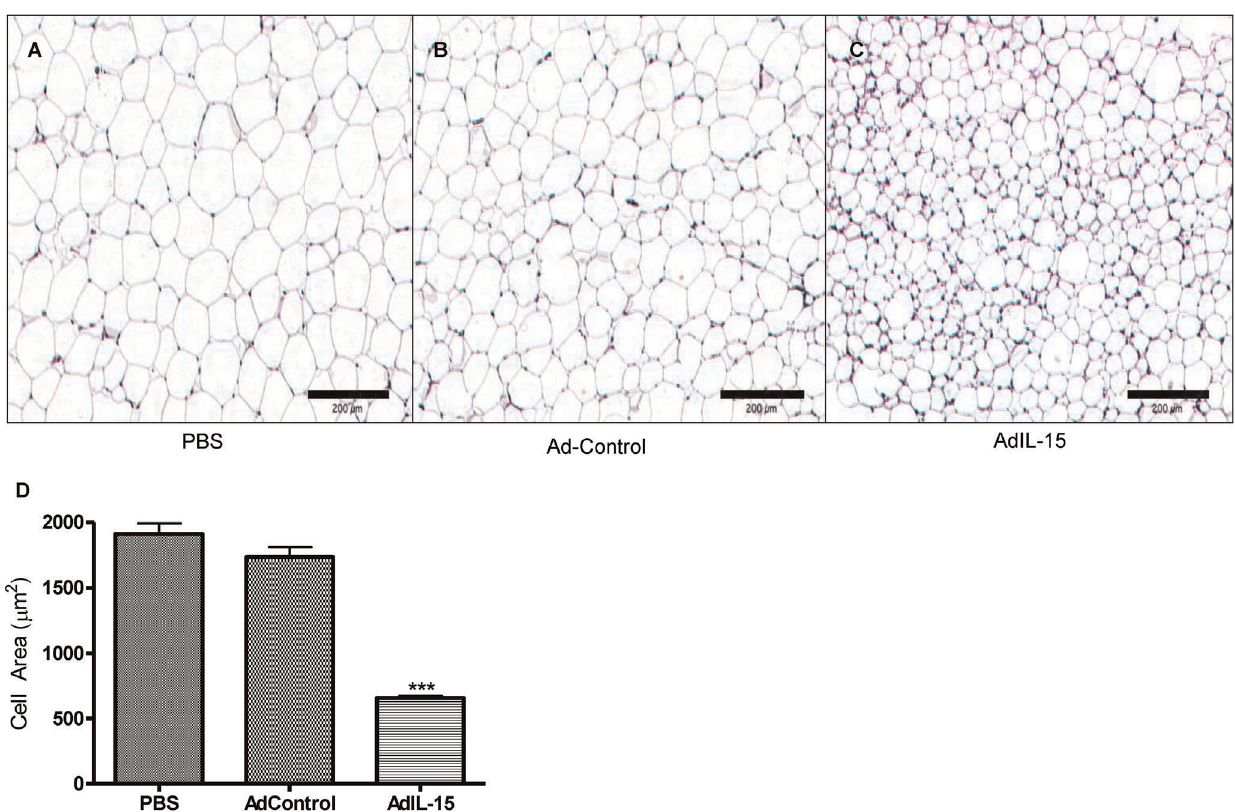
Figure 5. IL-15 treatment affects adipocyte size in RAG2 2 / 2 c c 2 / 2 mice. Representative cross sections of visceral gonadal fat pads excised from RAG2 2 / 2 c c 2 / 2 mice treated i.v. with ( A ) PBS, ( B ) AdControl, or ( C ) AdIL-15 were stained with hematoxylin and eosin (H&E). ( D ) Bar graph shows cell areas determined under 5 6 objective from each group determined using AxioVision software (n=5 per group). ***P , 0.001.